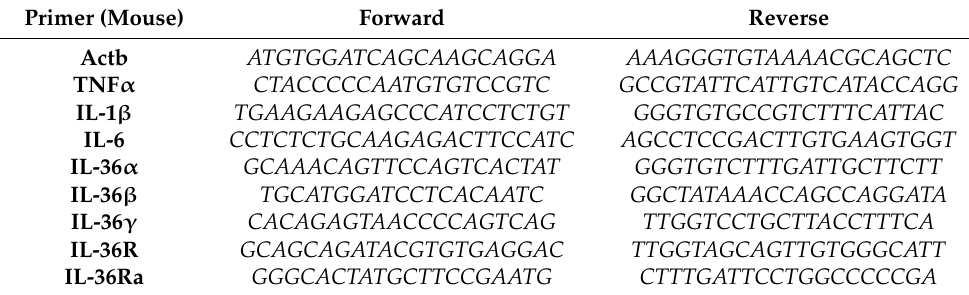
Table 1. Primer sequences used for semi-quantitative